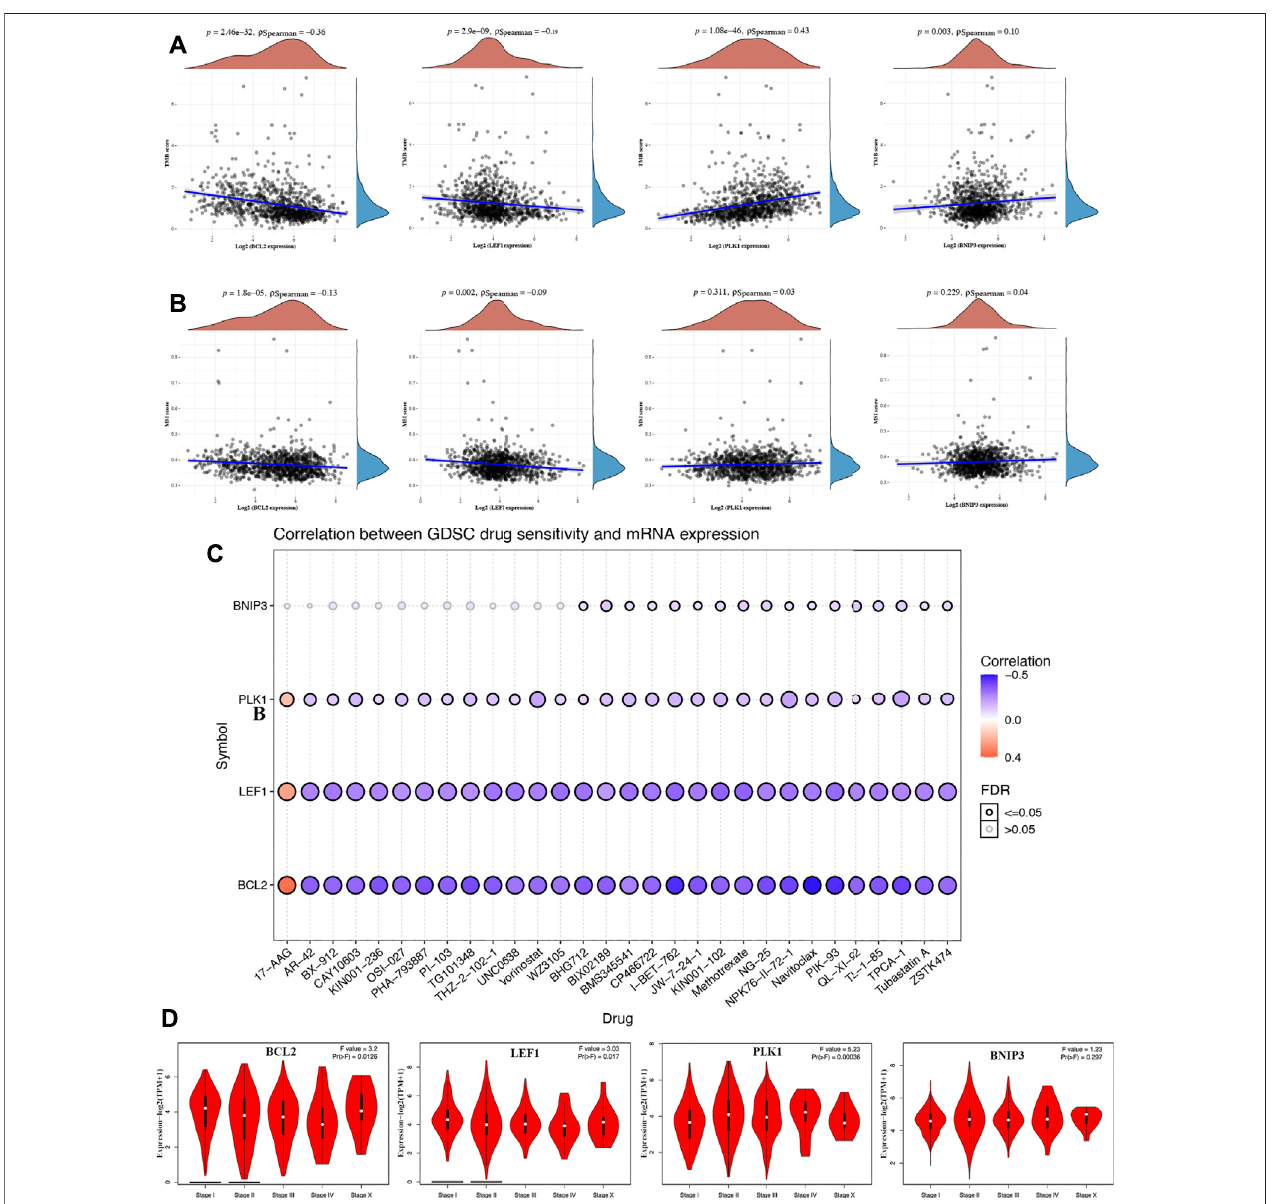
FIGURE6| ComprehensiveanalysisofBCL2, LEF1,PLK1,andBNIP3 inBRCA. Thecorrelation between necroptosis-relatedgenesand TMB (A) and MSI. (B,C) The correlation between necroptosis-related genes and drug IC50 of GDSC. (D) The correlation between necroptosis-related genes and pathology stage in BRCA. TMB, tumor mutation burden; MSI, microsatellite instability; GDSC, genomics of drug sensitivity in cancer.